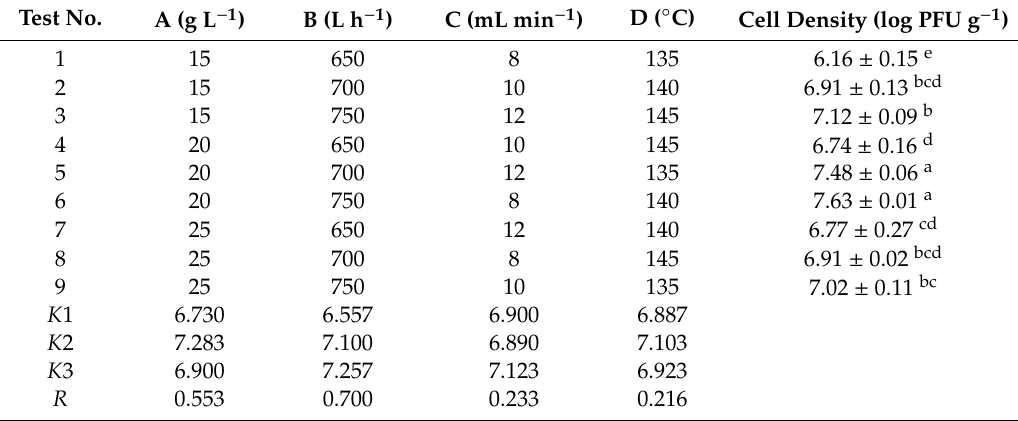
Table 1. L 9 (3 4 ) orthogonal design to investigate the e ff ect of experimental factors on cell densities of Bdellovibrio sp. strain F16 in the spray-dried